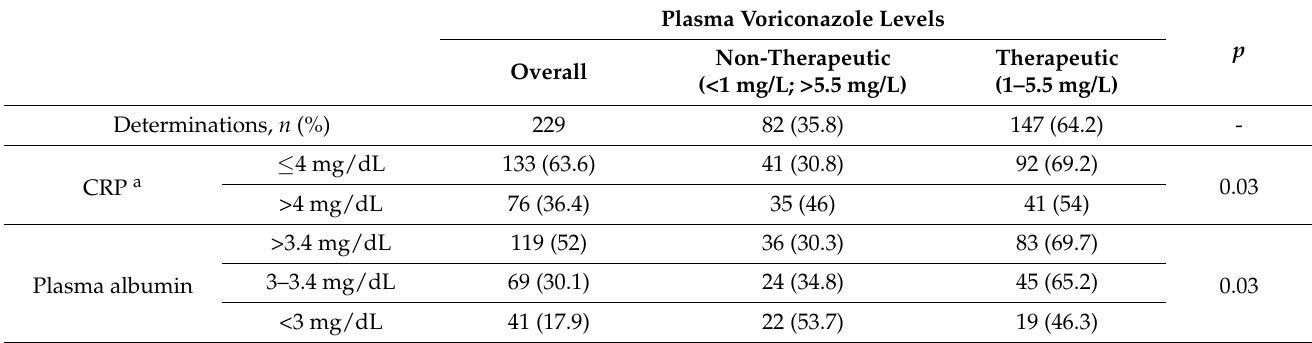
Table 4. Relationship between adequate voriconazole level and CRP and albumin